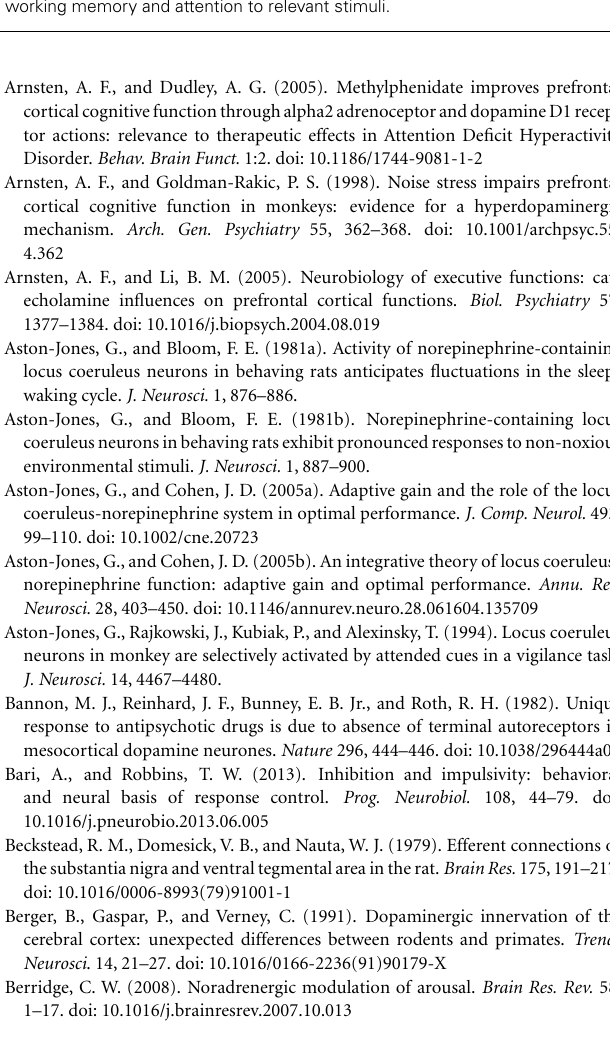
elevated, DA will be released in NAc, LC will be released in posterior cortical areas, and both catecholamines will be released in PFC.This may be beneficial during behavioral tasks which require sustained attention, as DA in NAc (green) will facilitate reward, NE in cortex (red) will alter the signal to noise ratio of pyramidal neurons to optomize them to specific stimuli, and both catecholamines in PFC (yellow) will work synergistically to facilitate working memory and attention to relevant